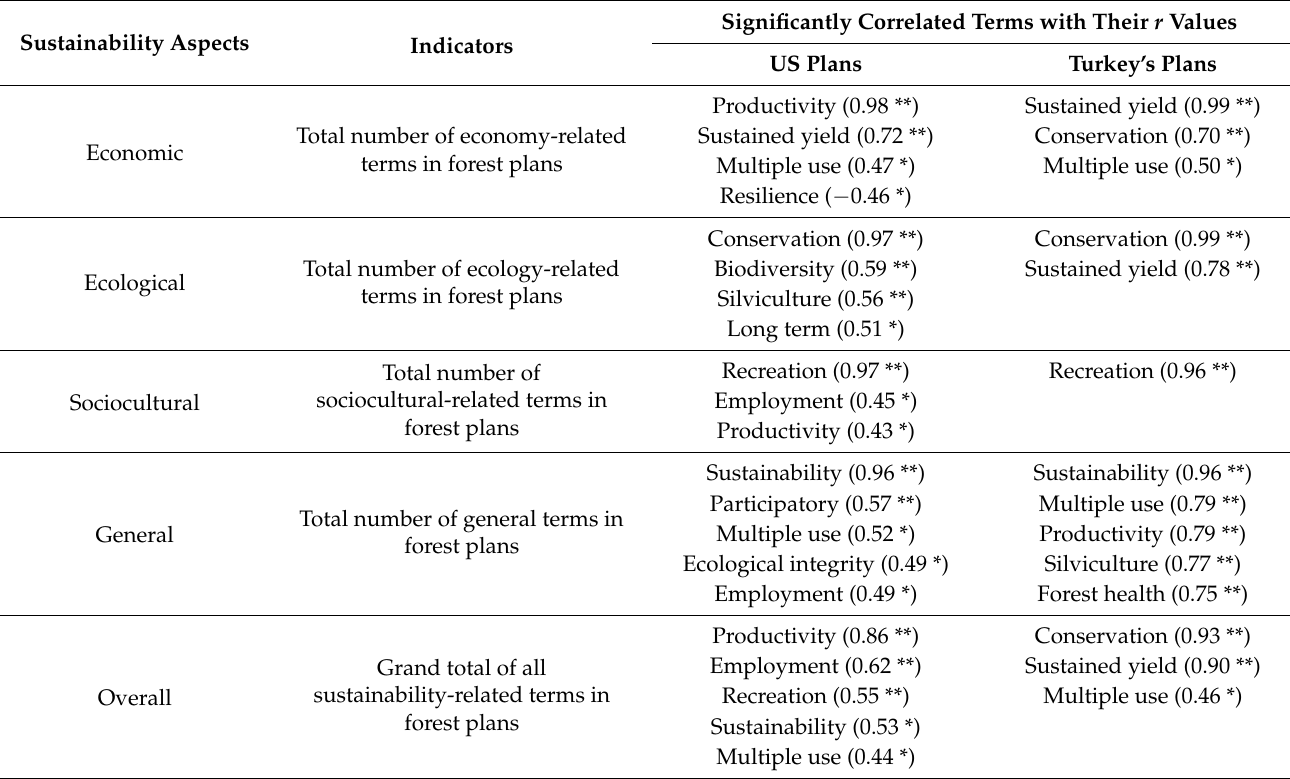
Table 5. The relationships between sustainability aspects and the occurrence of